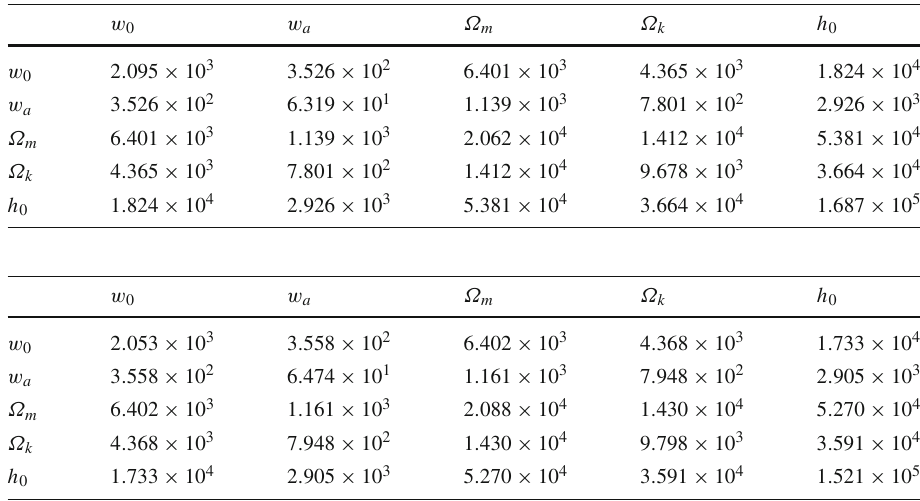
Table 5 The ET GW Fisher matrix for the uniform distribution of GW sources